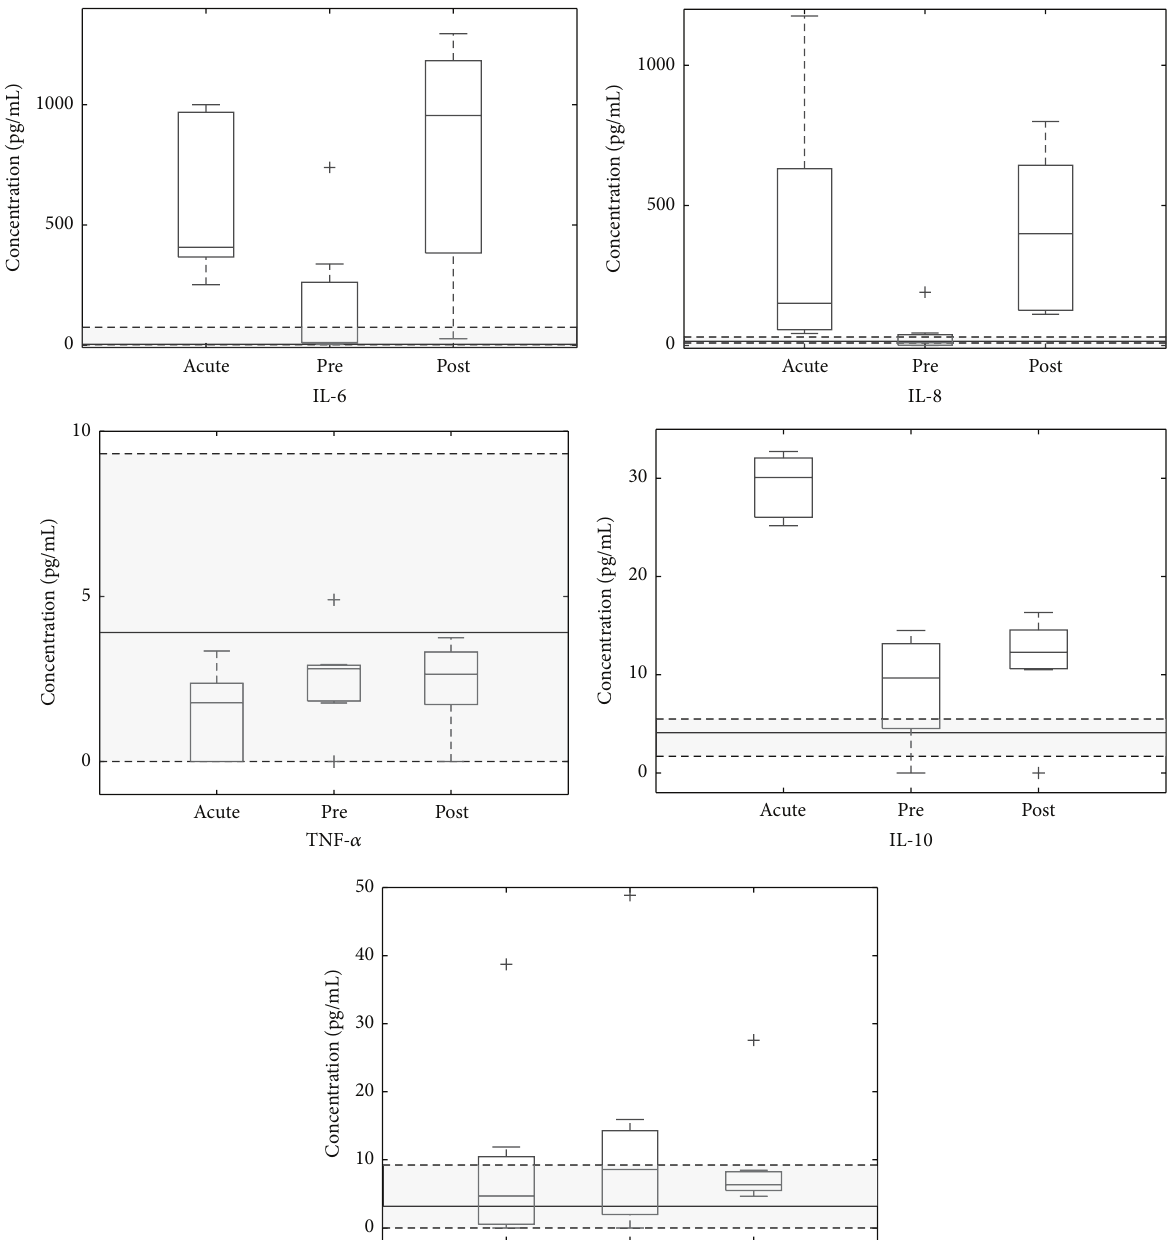
Figure 2: Time-related modifications of cytokine levels compared to chronic ACL group. Cytokine concentrations measured at different time points in the longitudinal group ( 𝑛 = 8 ) are represented in the box-plot. In each box-plot, the box is built within the third (upper bound) and first (lower bound) quartiles (i.e., 𝑄 3 , 𝑄 1 ); the middle line represents the median. Whiskers represent data maximum (upper whisker) and minimum (lower whisker). + indicates data outliers, defined as data points below 𝑄 1 − 1.5 × (𝑄 3 − 𝑄 1 ) or above 𝑄 3 + 1.5 × (𝑄 3 − 𝑄 1 ) . Grey shaded area represents the interquartile range of the chronic ACL tear group ( 𝑛 = 17